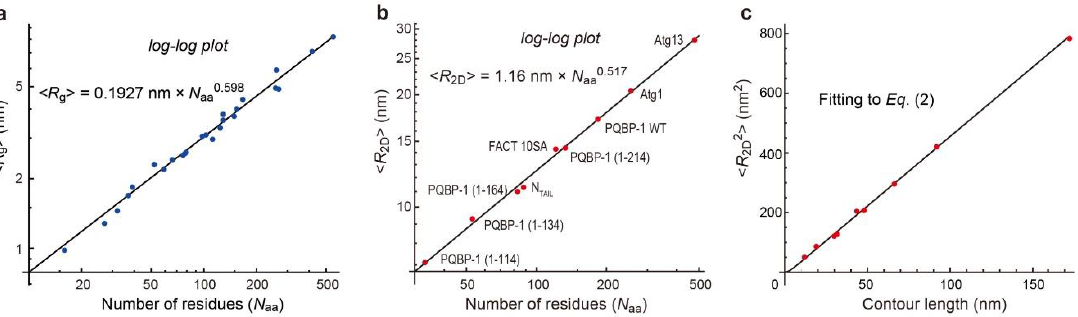
Figure 2. Relationship between molecular dimensions and the number of amino acid residues. ( a,b ) Power laws are found in chemically denatured proteins ( a ) and fully disordered regions within IDPs ( b ). The data in ( a ) are from the SAXS study by Kohn et al. [48]. The mean R 2D values, 〈 R 2D 〉 , in ( b ) are those for fully disordered IDRs observed in the indicated protein constructs. ( c ) The mean square of R 2D values, 〈 R 2D2 〉, of the nine IDP constructs shown in ( b ) are fitted to Eq. (2), from which the value of P 2D is estimated to be 1.16 nm. The number of residues in ( b ) is those contained in the fully disordered